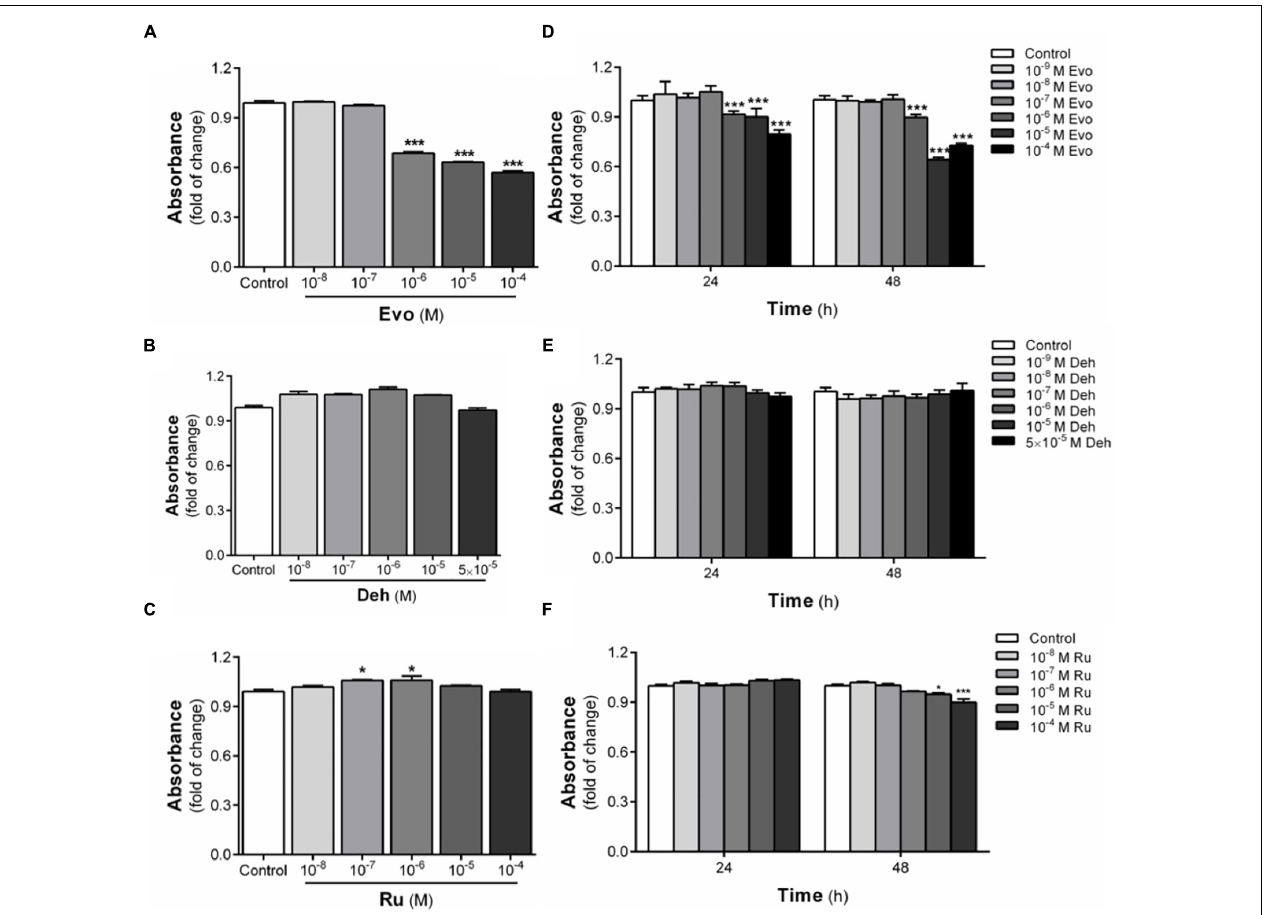
FIGURE 1 | Cytotoxicity of three bioactive substances in Evodia rutaecarpa. (A) Effect of evodiamine on cell viability of CBG2.8D cells; (B) Effect of dehydroaevodiamine on cell viability of CBG2.8D cells; (C) Effect of rutaecarpine on cell viability of CBG2.8D cells; (D) Effect of evodiamine on cell viability of U87 cells; (E) Effect of dehydroaevodiamine on cell viability of U87 cells; (F) Effect of rutaecarpine on cell viability of U87 cells was determined by CCK8 assay. * p < 0.05, *** p < 0.001 compared with control group. All values are fold of control that was treated with the solvent and represent the mean ± SEM ( n = 3). SEM, standard error of the mean; Evo, evodiamine; Deh, dehydroaevodiamine; Ru,